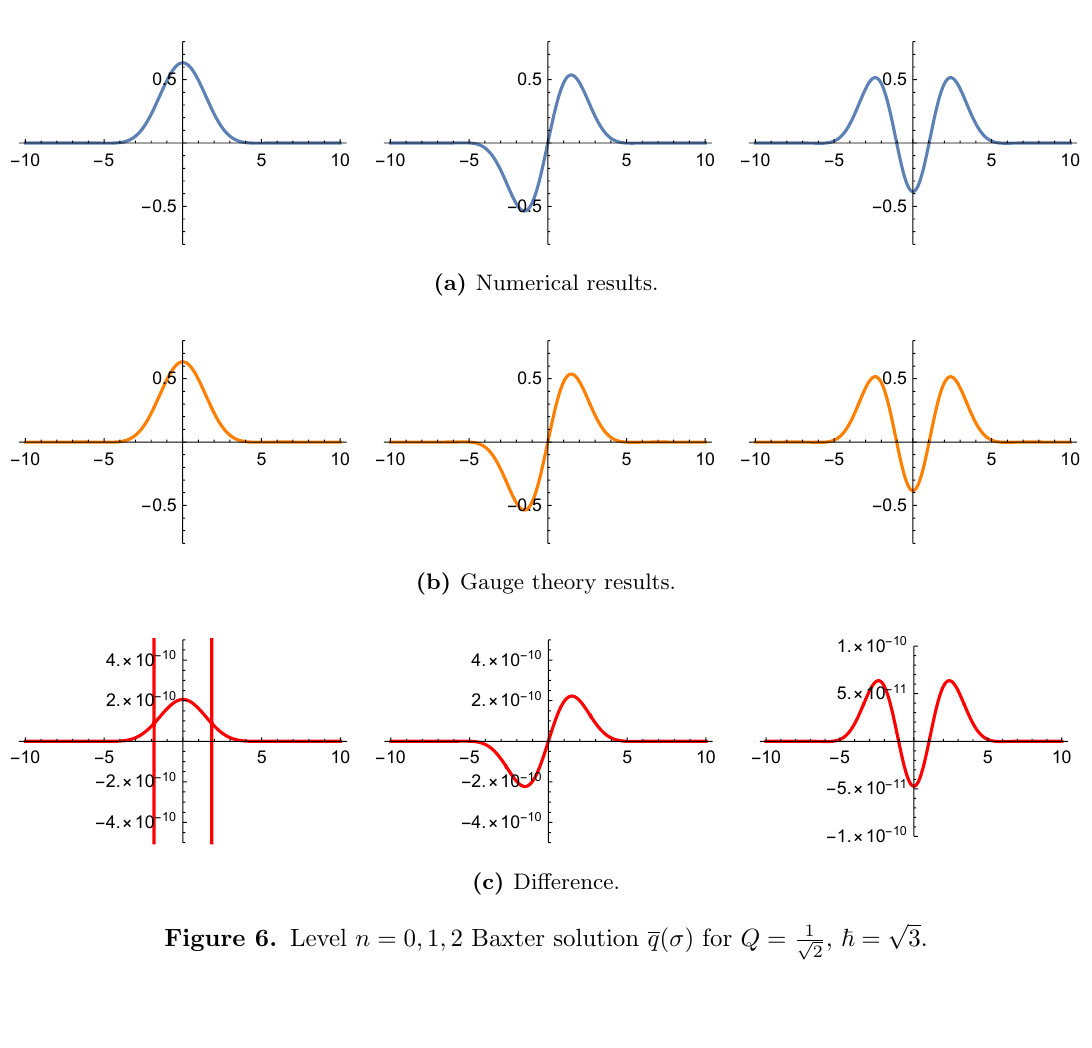
Figure 6. Level n = 0 ; 1 ; 2 Baxter solution q ( (cid:27) ) for Q = 1 p